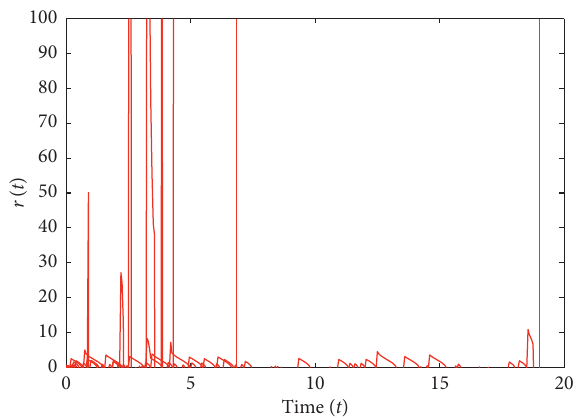
Figure 8: Unstable trajectory of r ( t ) of (45) with k � 0 . 01, θ � 0 . 5.